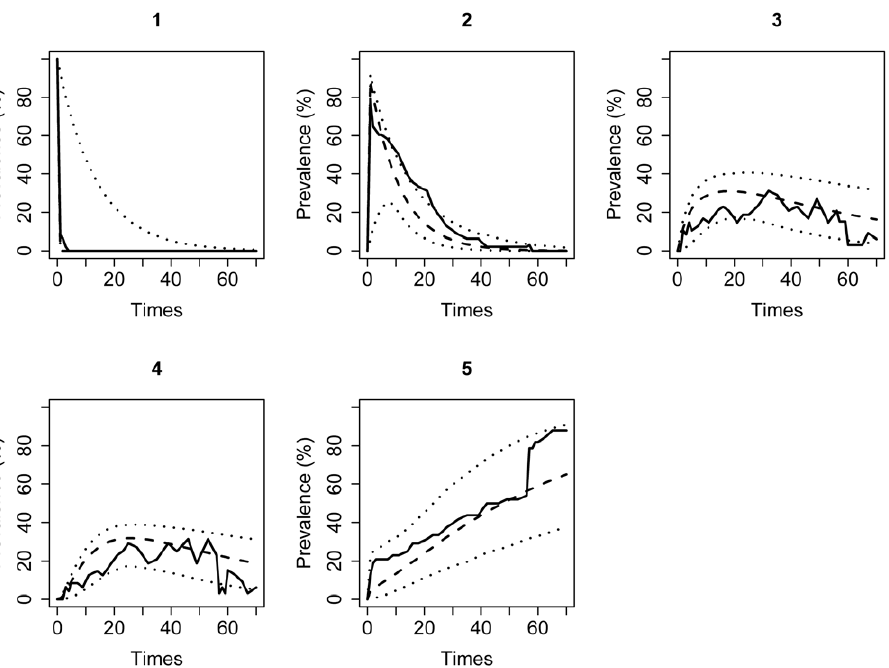
Figure 3. Observed versus expected prevalence of pigs in the states of the fecal shedding model. The 5 states are labeled 1, 2, 3, 4, and 5, denoting: 1-latency; 2-continuous shedding; 3-intermittent non-shedding state; 4-intermittent shedding state; and 5-recovery. Full line indicates the observed, while dashed and dotted lines denote mean and 95% CI of the expected prevalence.